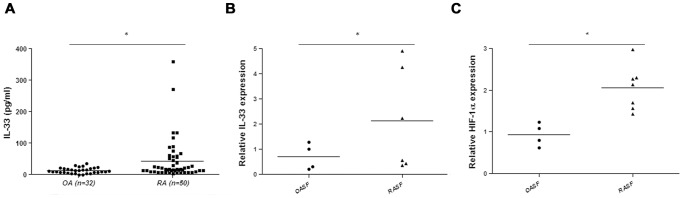
Elevated levels of IL-33 in RA patient synovial fluids.A, levels of IL-33 in the synovial fluids of RA patients (n = 50) and OA patients (n = 30) were detected by ELISA. The differences between the two groups were evaluated by Student’s t test. (*p<0.05). B, IL-33 expression levels were also determined by realtime PCR in the synovial fibroblasts of RA patients (RASF, n = 6) and OA patients (OASF, n = 4), one of the main producers of IL-33 (Wilcoxon signed-rank test, *p<0.05). C, Similarly, the expression levels of HIF-1α in RASF (n = 7) and OASF (n = 4) were also determined by realtime PCR (Wilcoxon signed-rank test, *p<0.05).